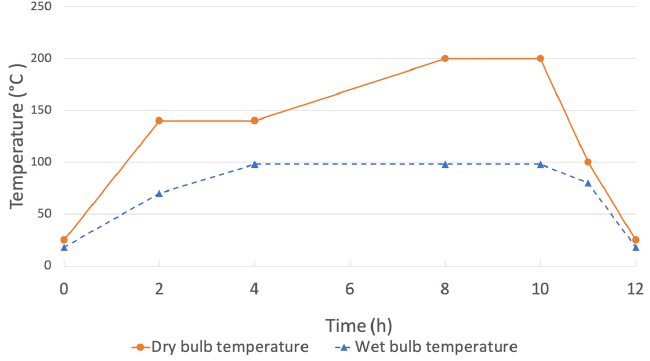
Figure 4. Schedule of thermal